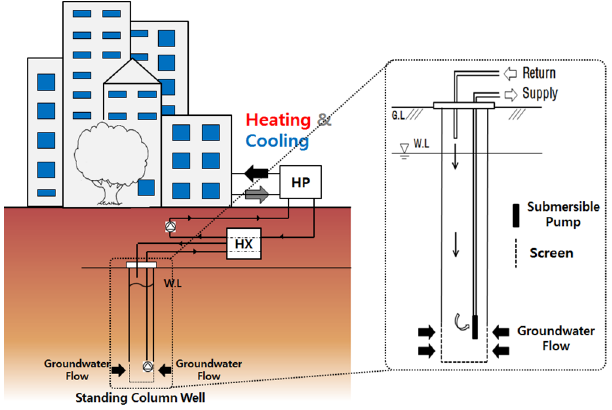
Figure 1. Standing Column Well (SCW) system.